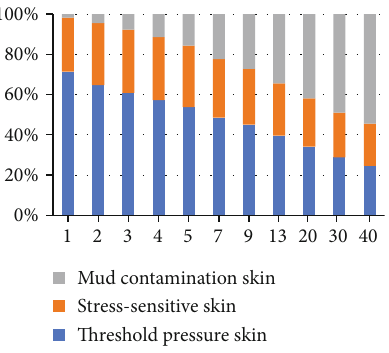
Figure 20: Skin corresponding to reservoirs with di ff erent permeability.